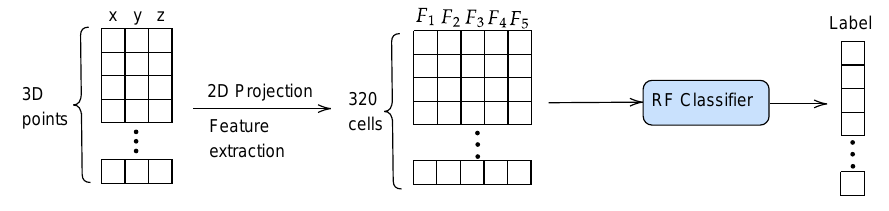
Figure 4. Pipeline for the prediction of cell traversability.